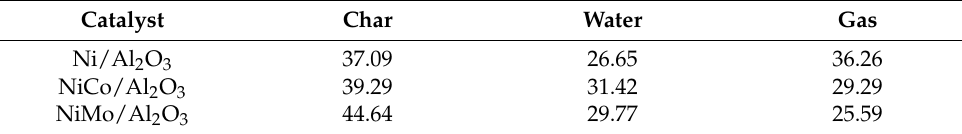
Table 4. Mass balance of catalyzed pressure pyrolysis of apricot stones